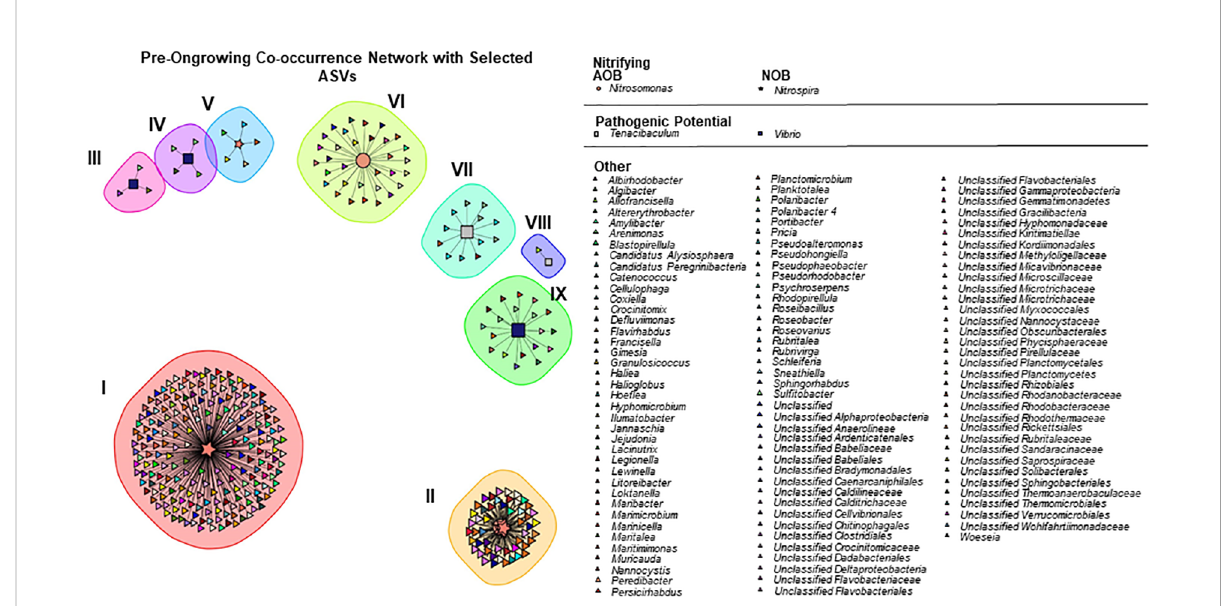
FIGURE 3 Correlations network in pre − ongrowing samples, coloured by Genus and shapes by function: pathogenic (squares), nitrifying oxidizing bacteria (stars), ammonia oxidizing bacteria (circles) and other